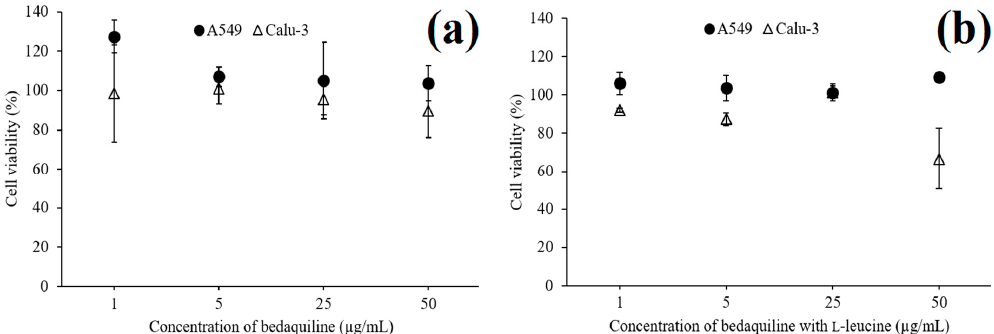
Figure 9. Cytotoxicity studies of spray-dried bedaquiline-only ( a ) and bedaquiline with L -leucine ( b ) powders using A549 cells and Calu-3 cells (data are means ± standard deviations, n = 3). On the other hand, although L -leucine containing bedaquiline powder showed no toxicity on A549 cells at 50 µg/mL, for the same concentration the powder was toxic to Calu 3 cells (< 67% cell viability) (Figure 9b). This formulation was safe for Calu-3 cells up to a concentration of 25 µg/mL. The greater cytotoxicity of SD-BL powder than the SD-B could be due to the enhanced permeability of SD-BL powder in the presence of surface active L -leucine [67,68].